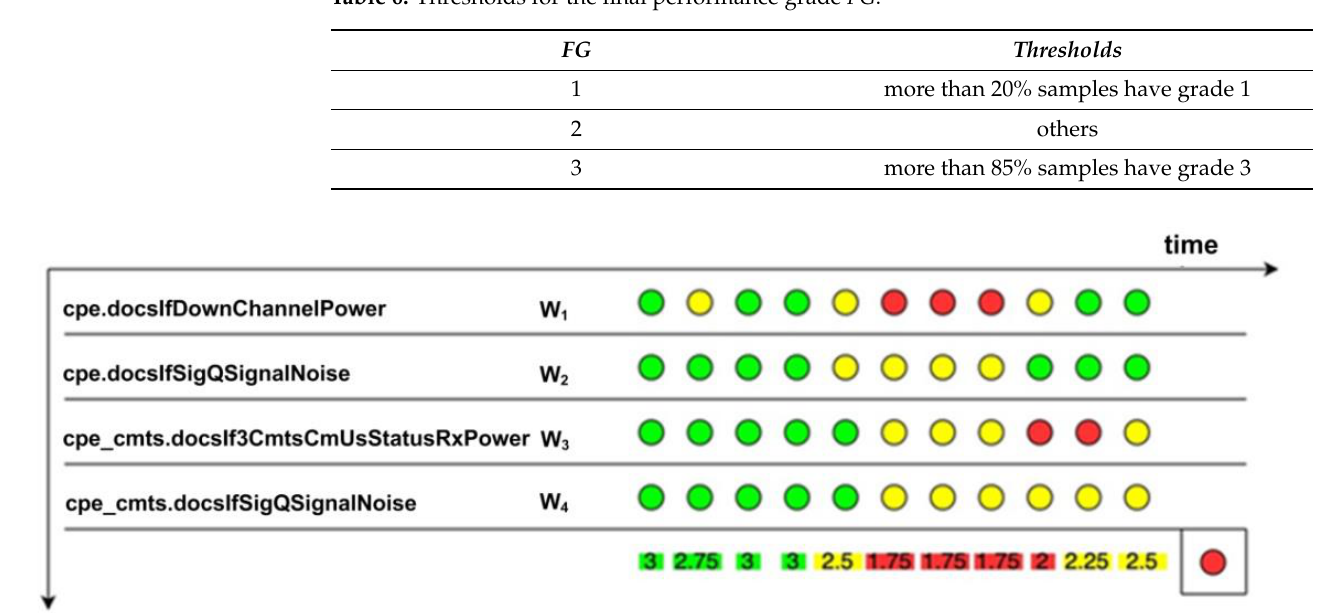
Figure 8. Final performance grade for CPE (red circle—grade 1, yellow circle—grade 2, green circle—grade 3).